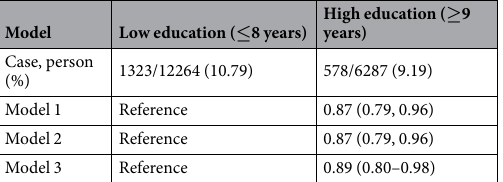
Table 2. HRs and 95% CIs for CHD incidence according to different educational levels. Model 1 adjusted for age. Model 2 adjusted for model 1 plus smoking, drinking, physical activity, marital status, stress, fruit